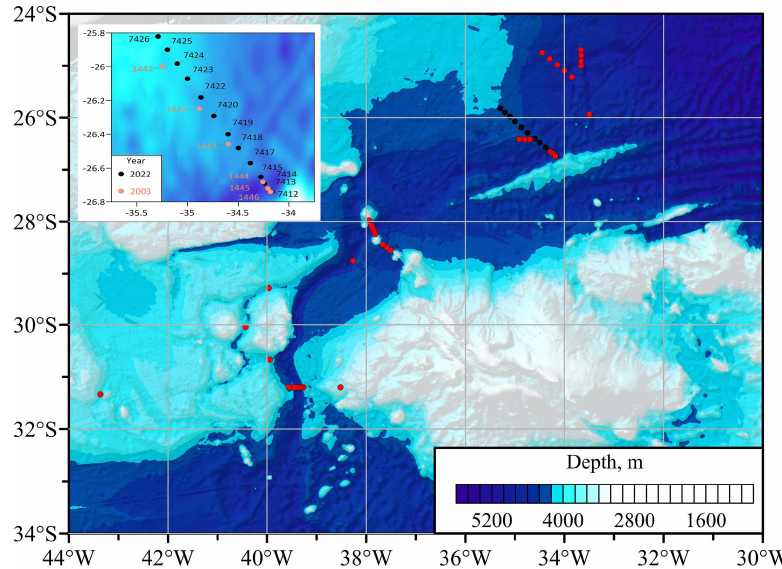
Figure 1. Bottom topography in the region of the Vema Channel (based on the GEBCO2019 data). Our stations in 2020 are indicated by red dots and those in 2022 are indicated by black dots. The inset shows stations in 2022 on a larger scale and stations in 2003 (dark yellow dots on the inset, not shown on the main map) approximately along the same line crossing the outflowing currents from the Vema Channel.